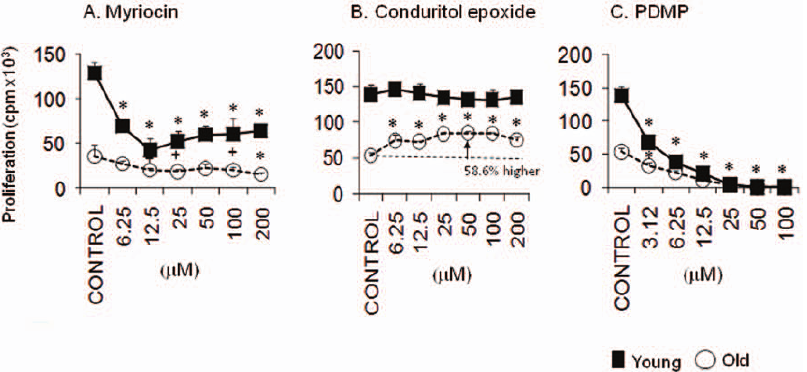
Figure 7. Inhibition of serine palmitoyl transferase activity with myriocin preferentially inhibits the proliferation of young CD4 + T cells, but suppression of Glc-Cer hydrolysis preferentially enhances the proliferation of Glc-Cer-poor aged CD4 + T cells. Young and old murine CD4 + T cells were treated with the indicated concentrations of (A) myriocin, (B) conduritol B epoxide (an inhibitor of glucosylceramide hydrolysis) or (C) PDMP (an inhibitor of glucosylceramide synthesis) and stimulated as in Figure 6. Proliferation assays and all statistical analyses were performed as in Figure 6A. Asterisks and plus signs respectively indicate p , 0.05 and p , 0.1 versus the corresponding untreated controls. The difference between the proliferation of control young and old CD4 + T cells is highly significant ( p , 0.001). One representative experiment of two is shown.